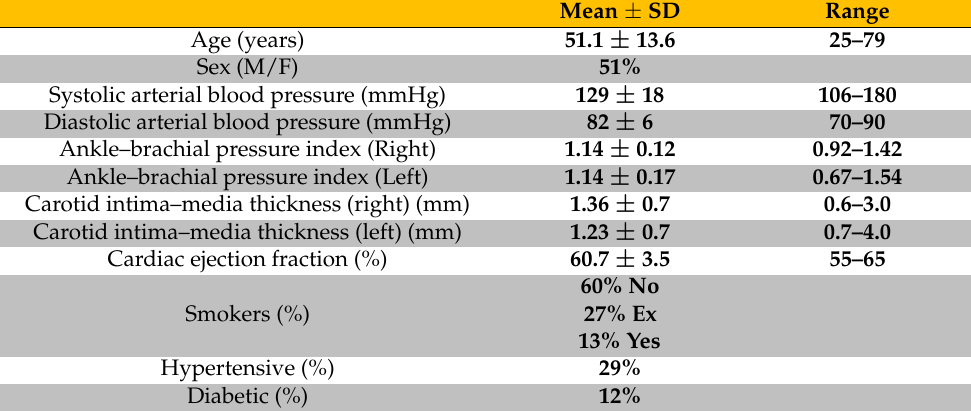
Table 1. Cardiovascular baseline data for 35 patients undergoing treatment with